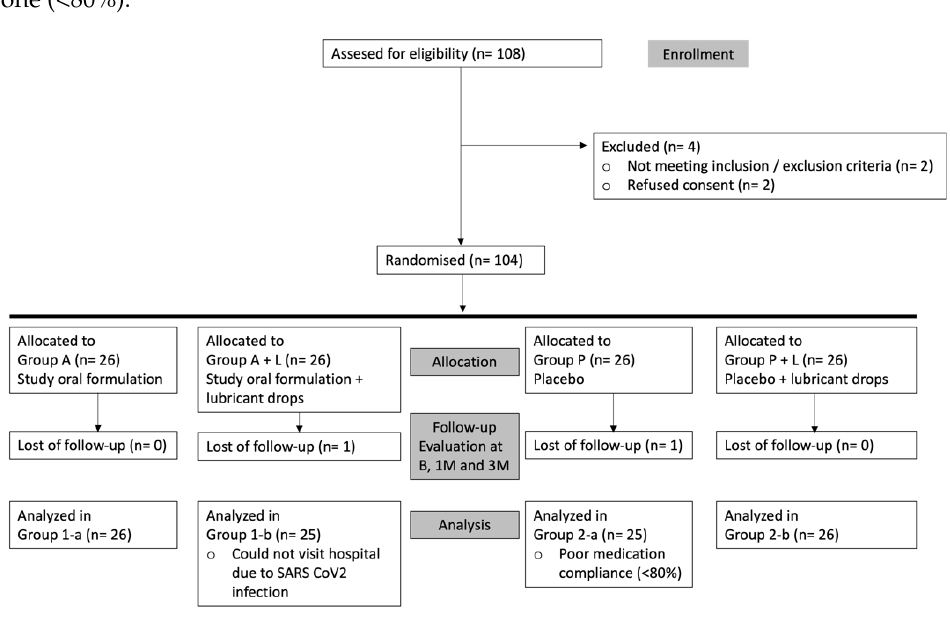
Table 4. Demographic and clinical characteristics of patients and study eyes of efficacy study groups.